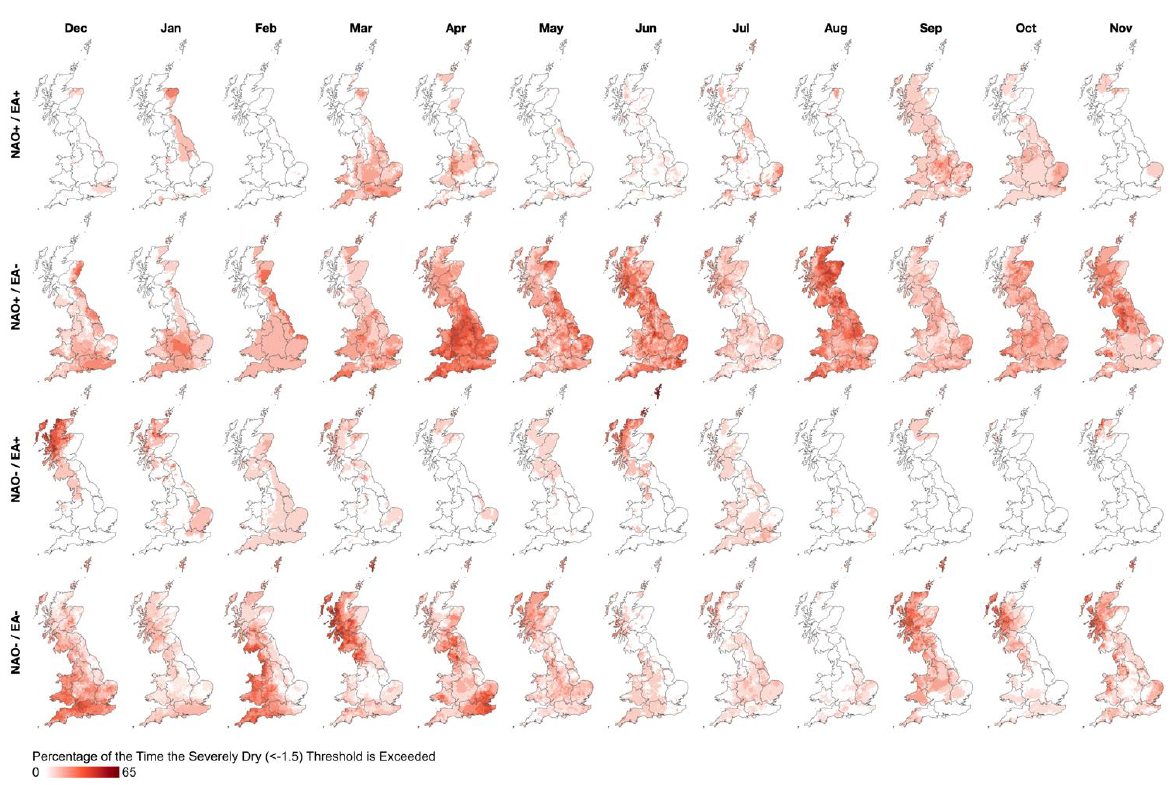
Figure 9. As per Figure 7 but for the extremely wet (SPI-1 > 2.0) SPI-1 class.